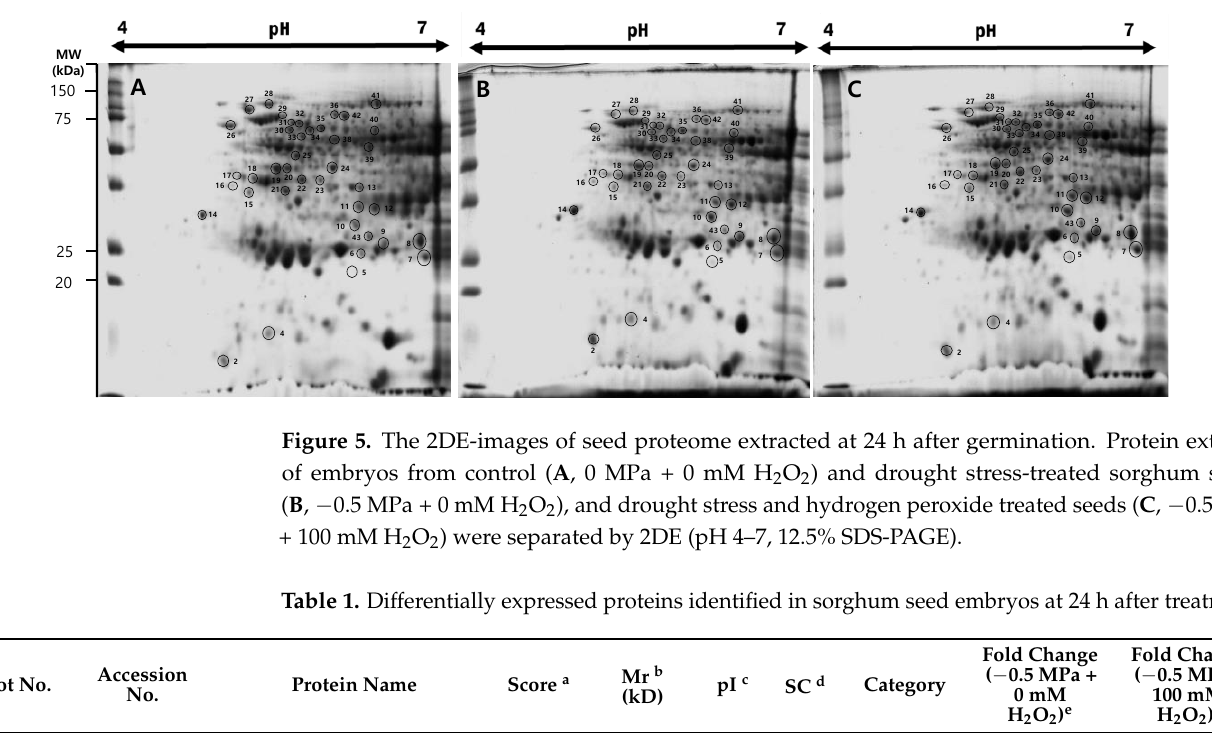
Superoxide dismutase [Mn] 3.4, mitochondrial